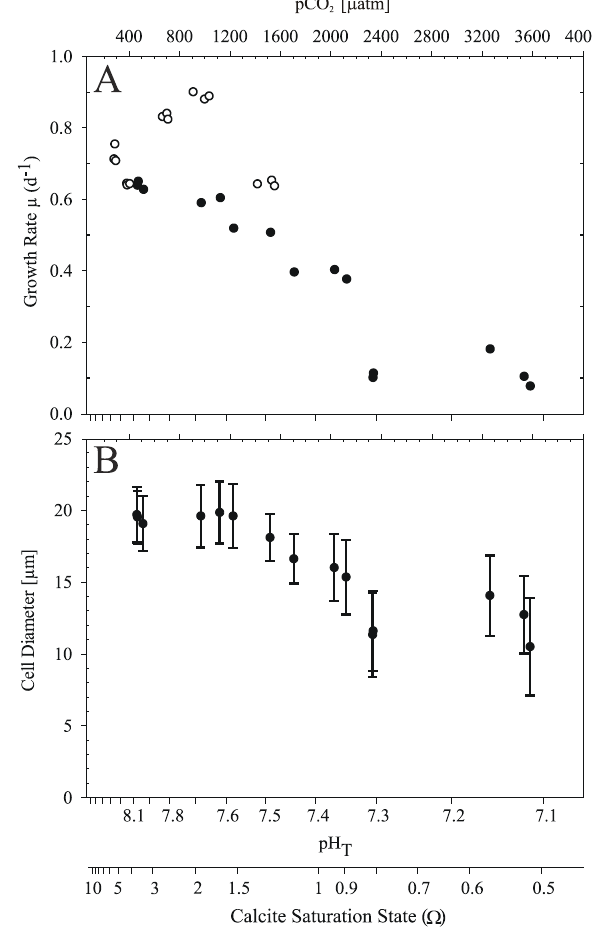
Fig. 2. Growth rates ( µ ) of Coccolithus braarudii in the first (filled circles) and second experiment (open circles) and together with cell diameter as measured in the first experiment in response to changing carbon chemistry speciation – (A) and (B) ,